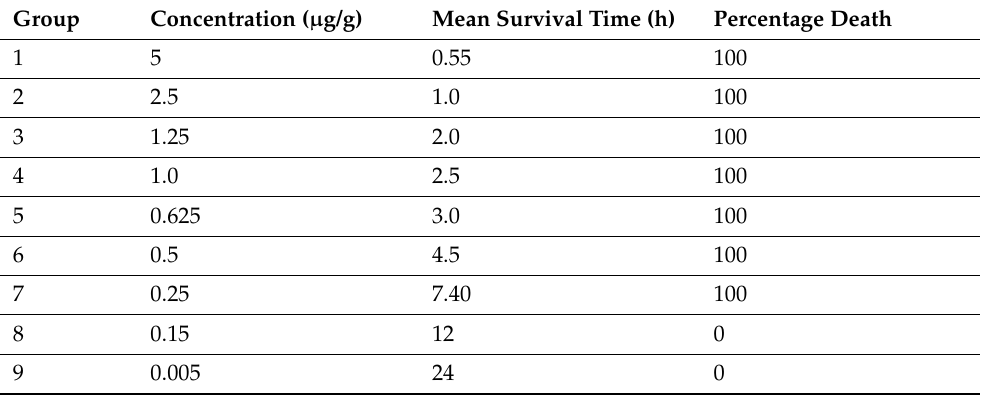
Table 1. Results of Lethal dose at various concentrations of N. melanoleuca venom with their mean survival time.